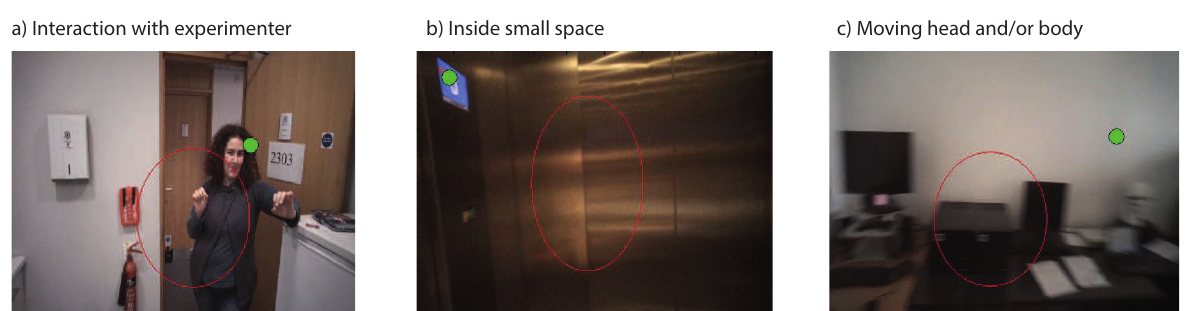
Figure 7 . Examples of frames where participants looked away from the central location. Visual inspection suggested that such frames mostly involved (1) interacting the with experimenter, (2) gaze during head and body movements (visible as blur in the image), and (3) when inside small spaces (like inside a